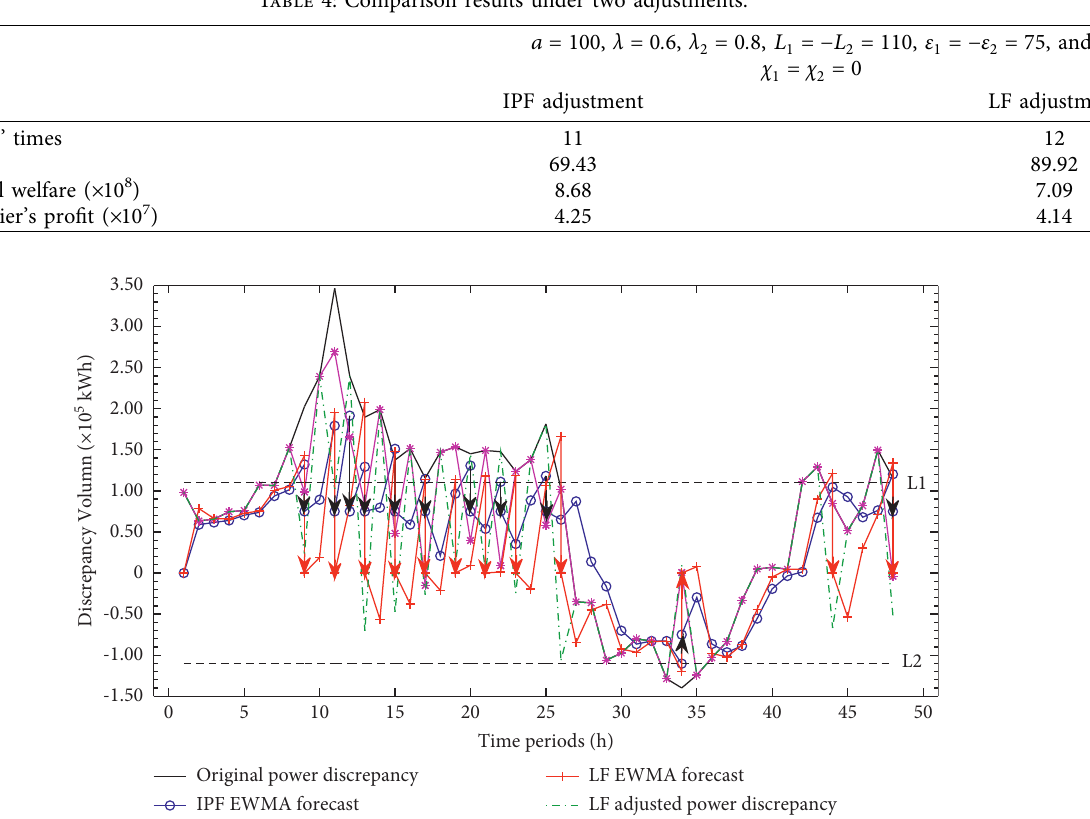
Figure 4: Economic benefits of both sides (histogram depicts whole social welfare and red solid lines with point markers denote profit). Table 4: Comparison results under two adjustments.